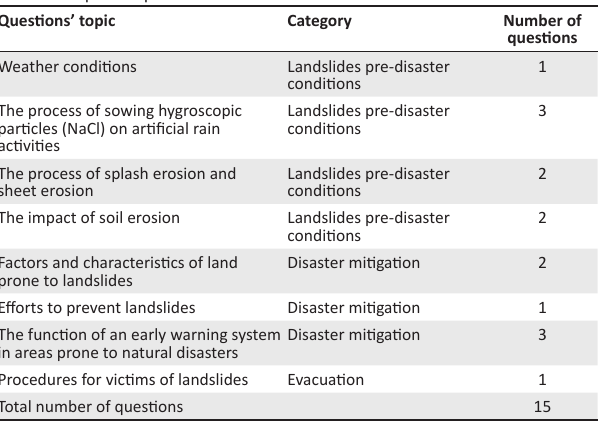
TABLE 1: Topics of